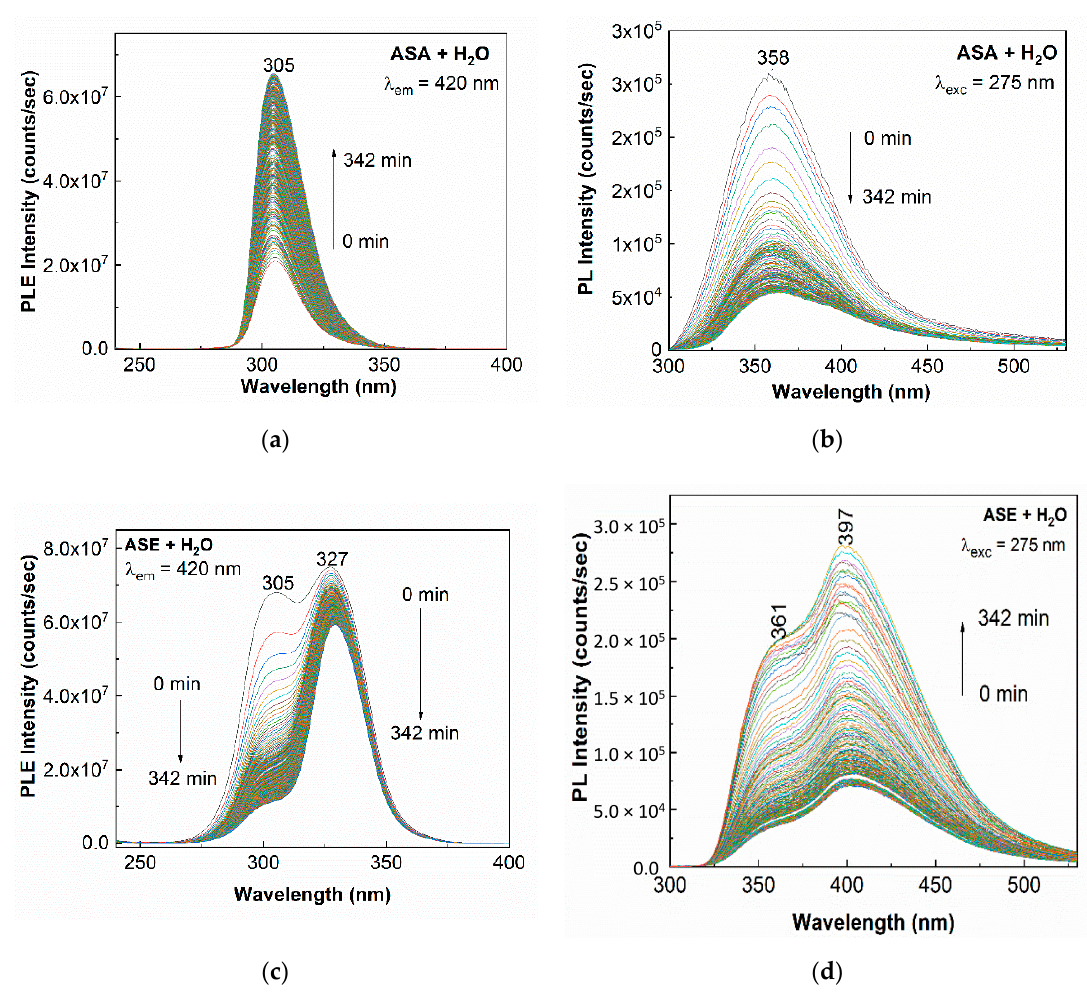
Figure 2. PLE and PL spectra recorded under the emission wavelength of 420 nm and the excitation wavelength of 275 nm, respectively, of the aqueous solution of ASA 0.3 M ( a and b ) and ASE 0.3 M ( c and d ).